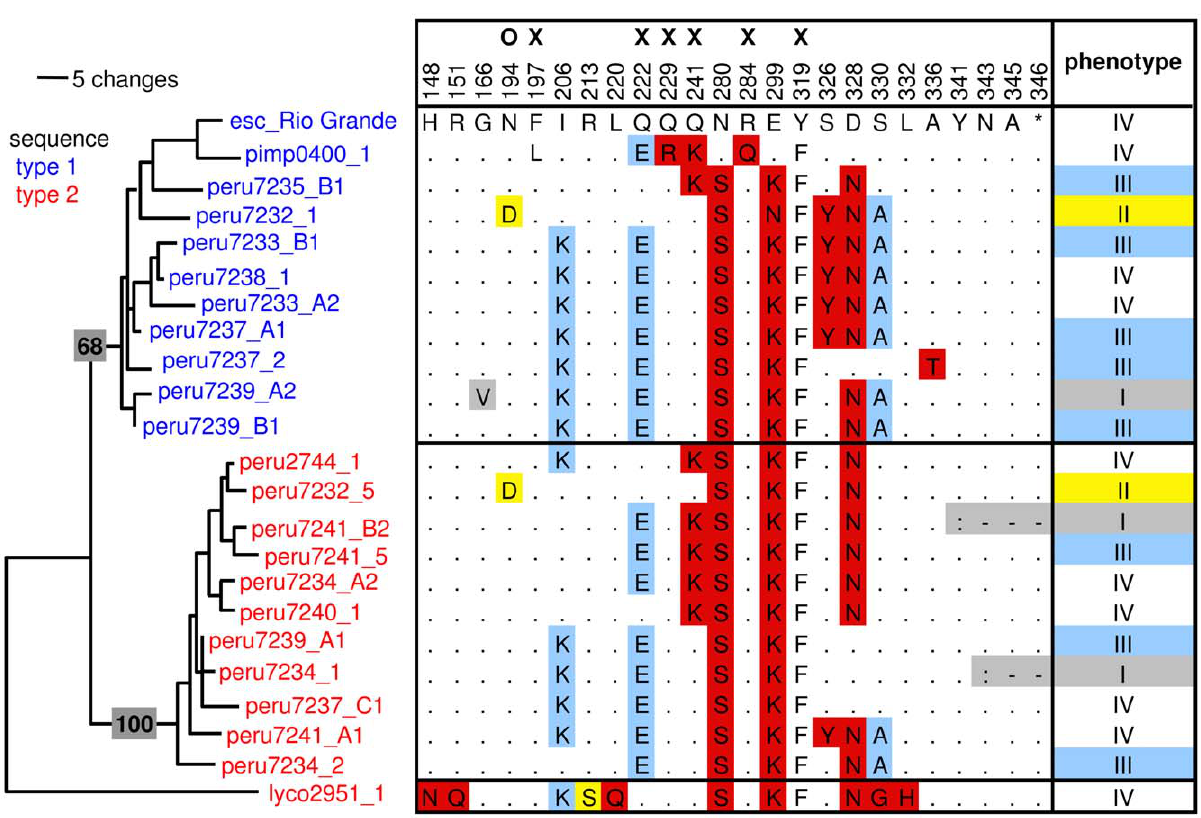
Figure 2. Overview of a subset of RCR3 protease domain haplotypes, their phenotype, and position in the RCR3 gene tree. The tree (MP) containing a subset of RCR3 sequences is based on Figure S4 with S. lycopersicoides as outgroup. Bootstrap support is indicated on the branches. The protein sequence of S. lycopersicum is used as a reference (esc_Rio Grande). Sequences are named according to their species, their accession or individual number and their origin from Locus A , B or C in those cases for which unambiguous assignment was possible. Sequences from sequence type 1 are labeled in blue; sequences from sequence type 2 are labeled in red. In the haplotype matrix, identical amino acids are indicated with dots, similar amino acids with the according letter, dissimilar amino acids with red and functionally relevant amino acid changes with yellow and blue according to their phenotypic association using all RCR3 constructs. X=mutation putatively causing incompatibility with Cf-2 [56], O=mutation causing insensitivity to inhibition by AVR2 [24]. Phenotype I=not accumulated in AF, II=not inhibited by AVR2 and no HR, III=inhibited by AVR2 and attenuated HR, IV=inhibited by AVR2 and strong HR.